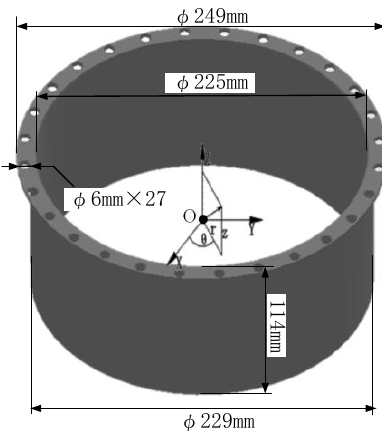
Figure 14. Aero engine case.